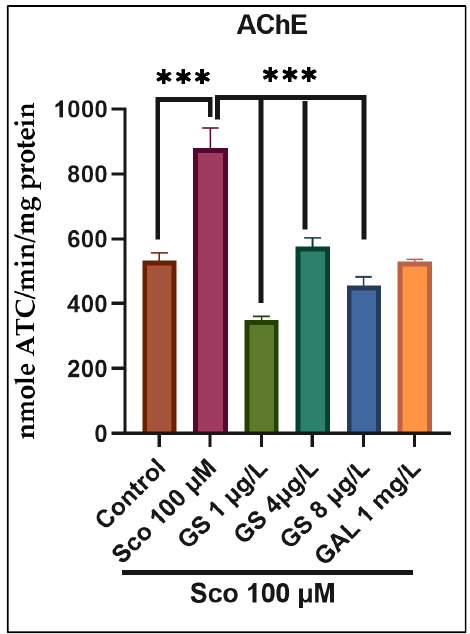
Figure 5. Effects of Guiera senegalensis hydroethanolic extract (GS: 1 μ g/L, 4 μ g/L and 8 μ g/L) on Sco ‐ induced increasing in the activity of the acetylcholinesterase (AChE). Each column represents mean ± S.E.M. of 10 zebrafish. For Tukey’s post hoc analyses: *** p < 0.0001.